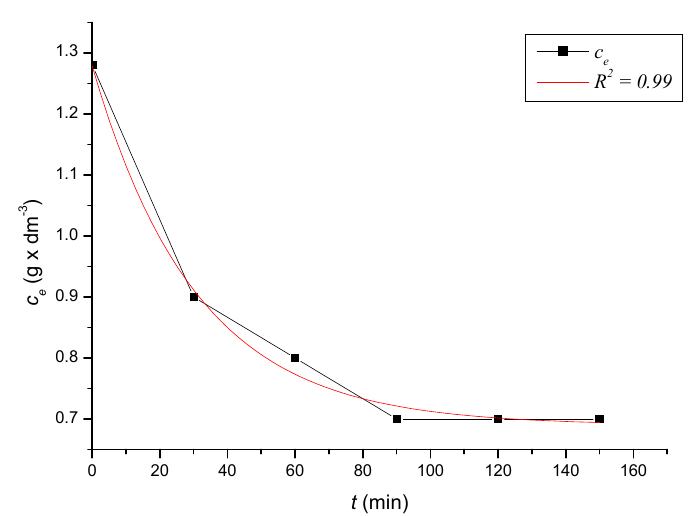
Figure 6. The kinetic course of reducing the concentration of Fe 3+ cations in a solution with an initial concentration of 1.28 g × dm −3 by the action of clinoptilolite.